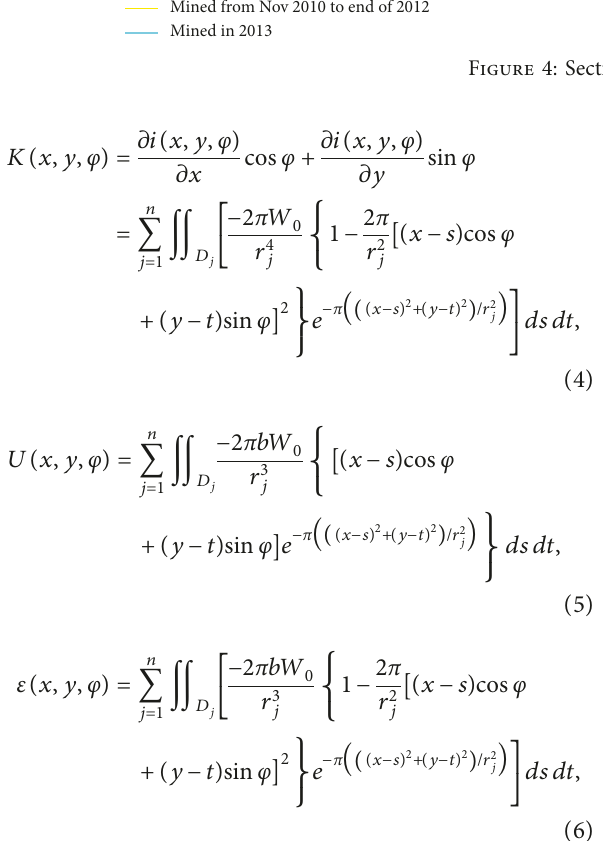
sidence in the nearby area.